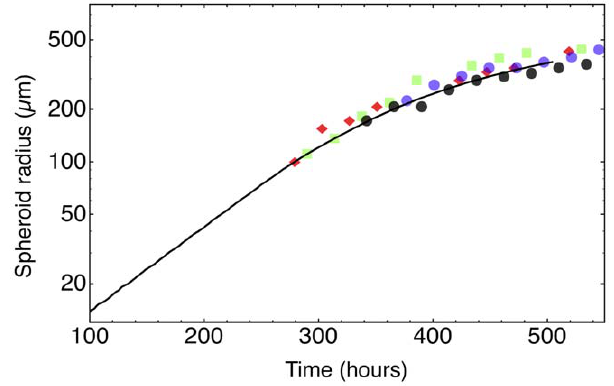
Figure 4. Growth curve of a simulated tumor spheroid (solid line). The run parameters used in this case are listed in Text S1. The symbols denote data points taken in different in vitro experiments: squares=FSA cells (methylcholantrene-transformed mouse fibroblasts) [45]; diamonds=MCF7 cells (human breast carcinoma) [19]; circles=9L cells (rat glioblastoma) [27].